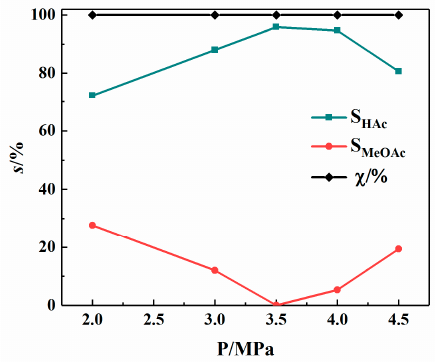
Figure 10. Catalytic performance of Rh(I) / Ru(III) bimetallic catalysts at di ff erent pressures (T = 190 ◦ C; t = 60 min; w(CH 3 COOH) = 54 wt%; w(H 2 O) = 6 wt%; x / %: conversion rate of methanol).